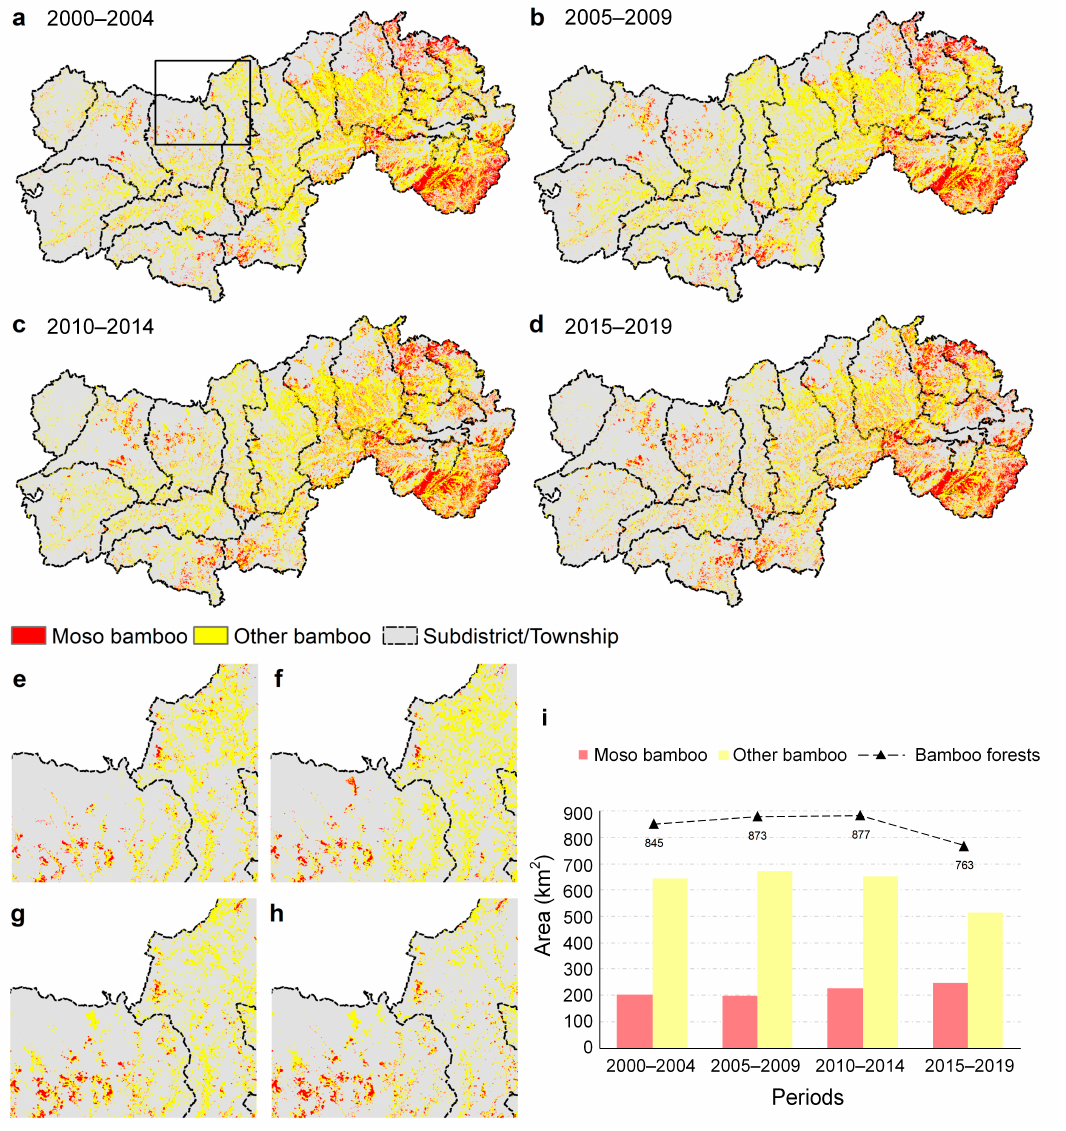
Figure 5. ( a – d ) The bamboo forest maps for the four periods. ( e – h ) show zoom-in views corresponding to the black box in Figure 5a. ( i ) Bamboo forest areas in the four